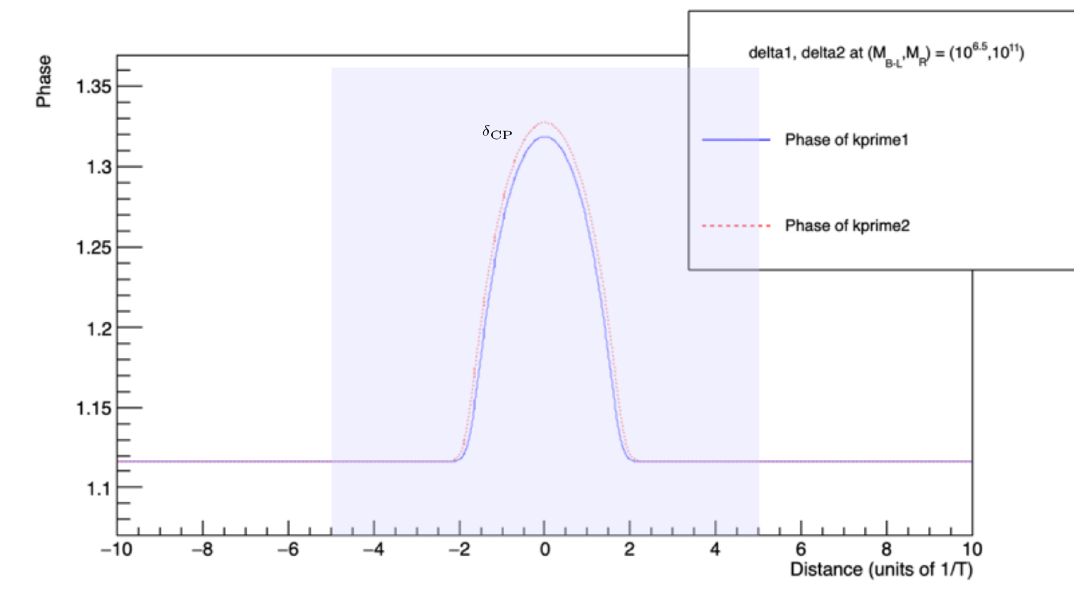
Figure 4 . The phases of k 0 and figure